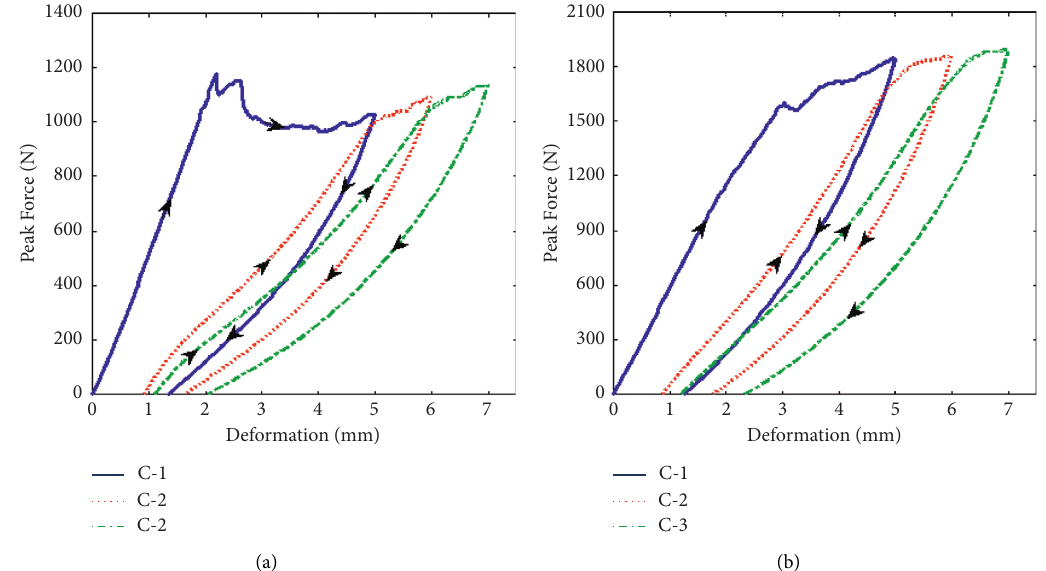
Figure 5: Effect of phases of reinforcement under cyclic indentation: (a) bidirectional glass/epoxy and (b) chopped